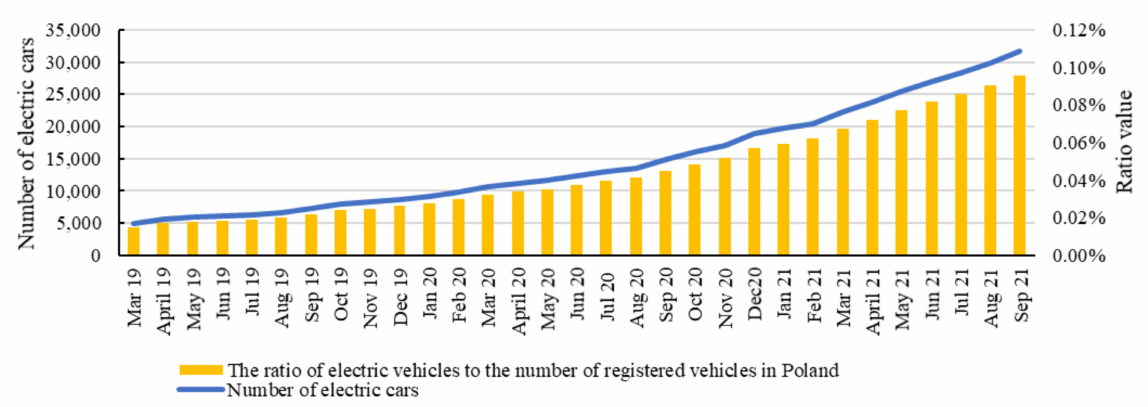
Figure 2. Number of registered electric cars in Poland in